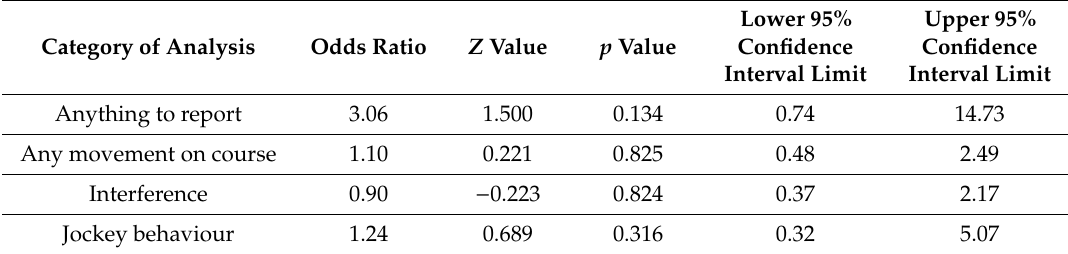
Table 4. The odds ratios, z values, p values and 95% confidence intervals for reports in a WP race, compared to the control of a WF race where whips are held but not used.